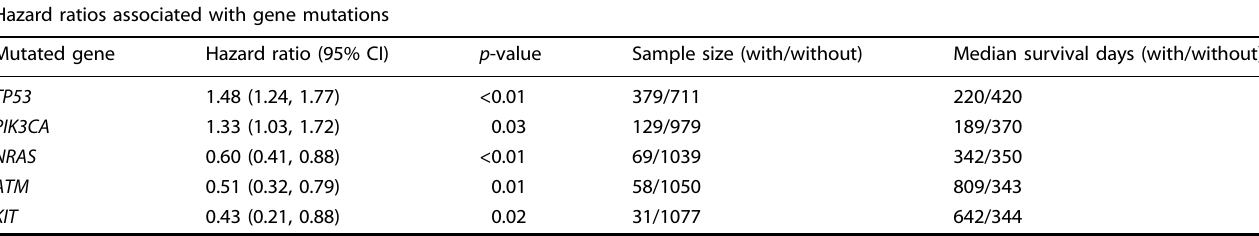
Table 2. Statistically signi fi cant hazard ratios associated with mutations in each gene, con fi dence intervals, p -values, sample sizes, and median survival in